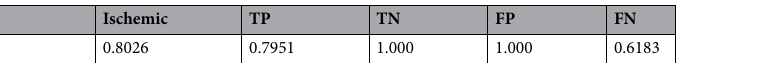
Table 3. Cohen’s Kappa ( κ ) calculated for the CNN and the clinical interpretation indicating agreement between classification of the subjects to categories of ischemic, TP, TN, FP and FN. Good agreement is reached in all categories. The lowest agreement was reached in subjects labeled as FN.